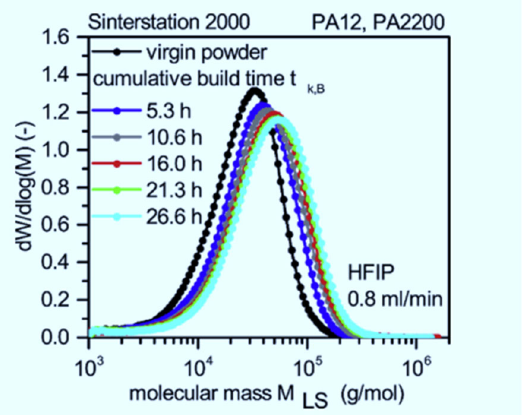
Figure 2. Effects of cumulative build time on the average molecular weight of PA 12 [16].